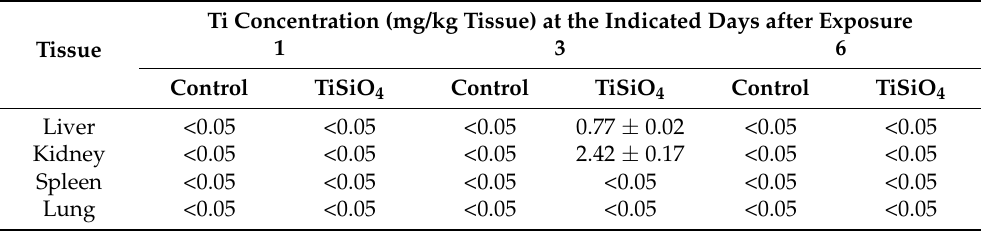
Table 7. Titanium content (mg/kg tissue) in male rat liver, kidney, and spleen tissues after 1, 3,